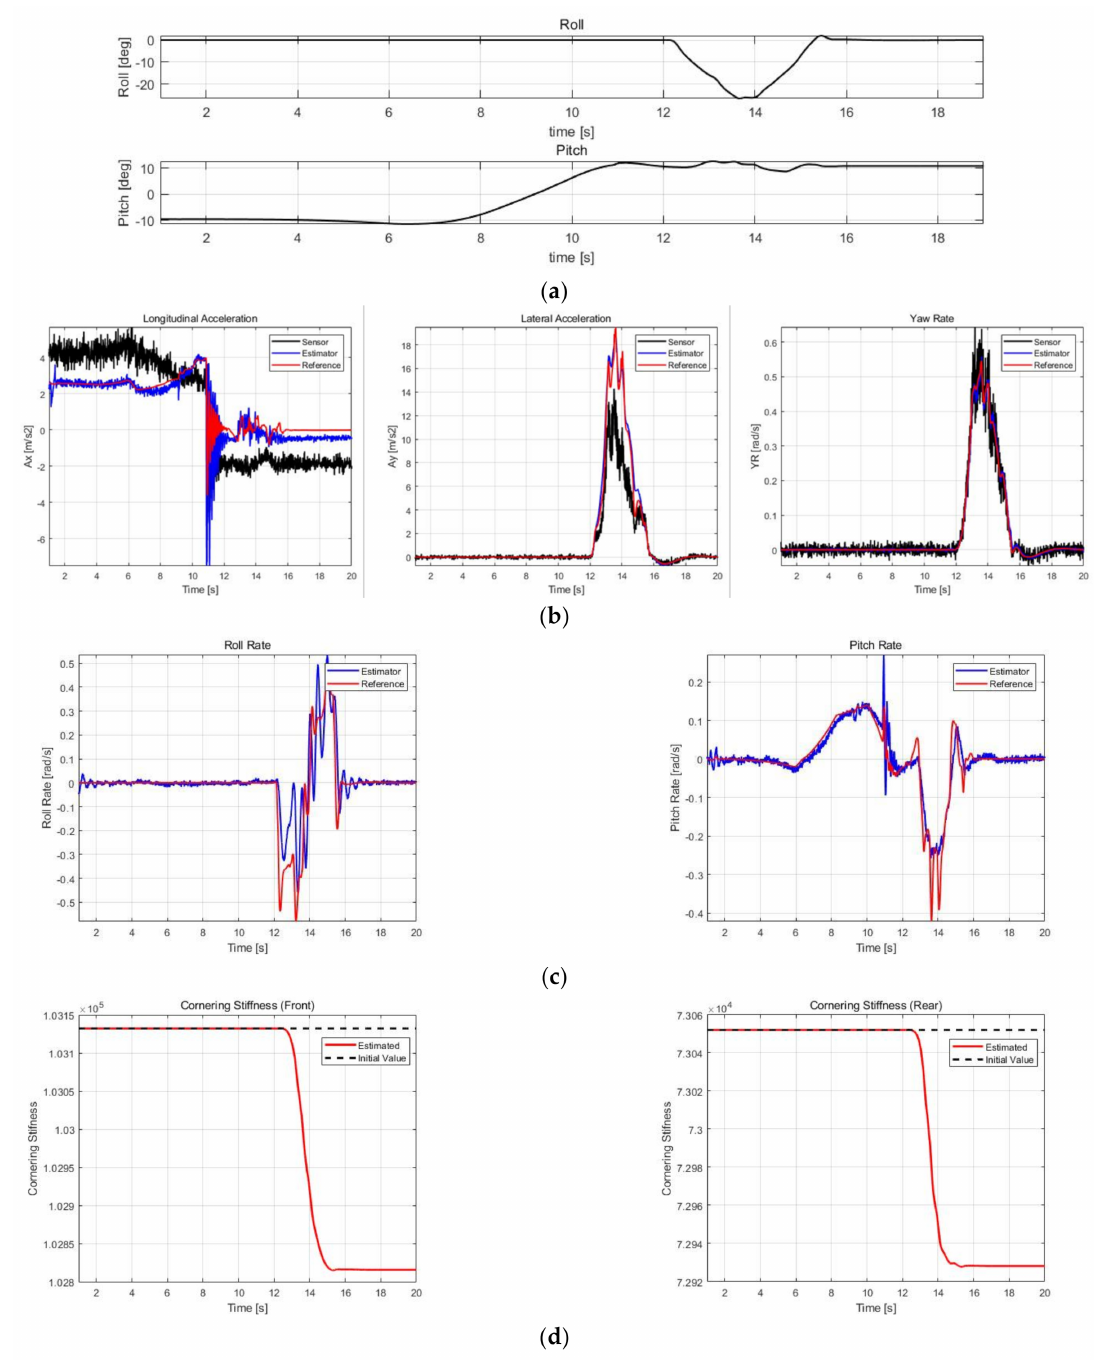
. ψ estimation results.